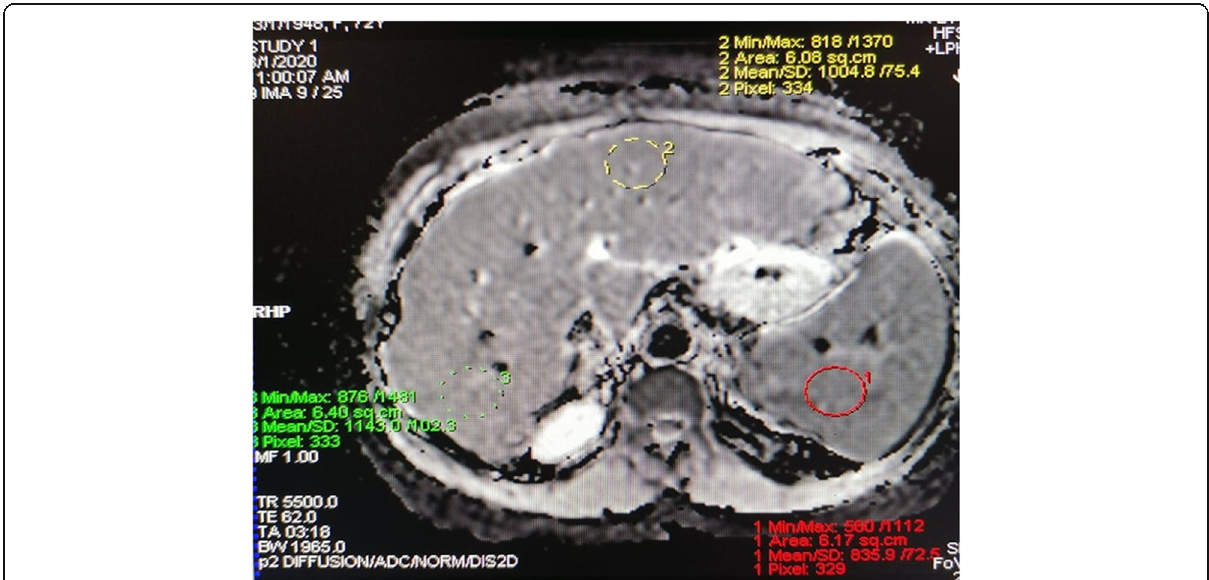
Fig. 2 DW-MR ( b = 800) image and ADC map of the liver and the spleen for a case of F3 stage [mean liver ADC value = 1102.8 mm 2 /s, mean spleen ADC value = 830.2 mm 2 /s, and liver/spleen ADC =